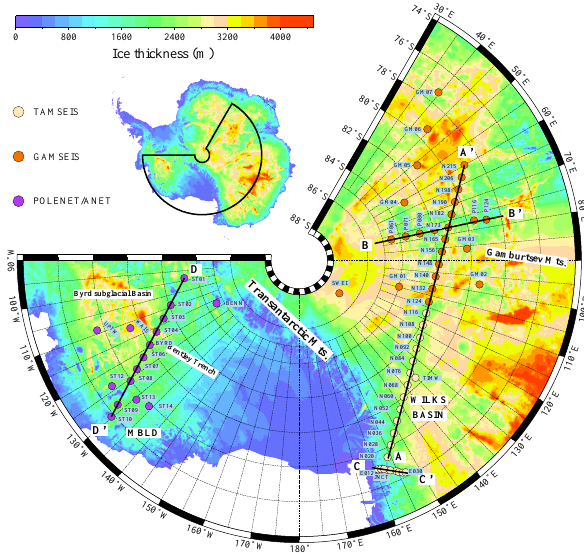
Figure 1. Locations of the three seismic arrays used in this study. Some stations are connected with lines to form four profiles marked with AA’, BB’, CC’ and DD’. TAMSEIS: TransAntarctic Mountains Seismic Experiment; GAMSEIS: Gamburtsev Antarc- tic Mountains Seismic Experiment; POLENET/ANET: The Polar Earth Observing Network/Antarctic Network. Ice sheet thickness data in this plot come from Bedmap2